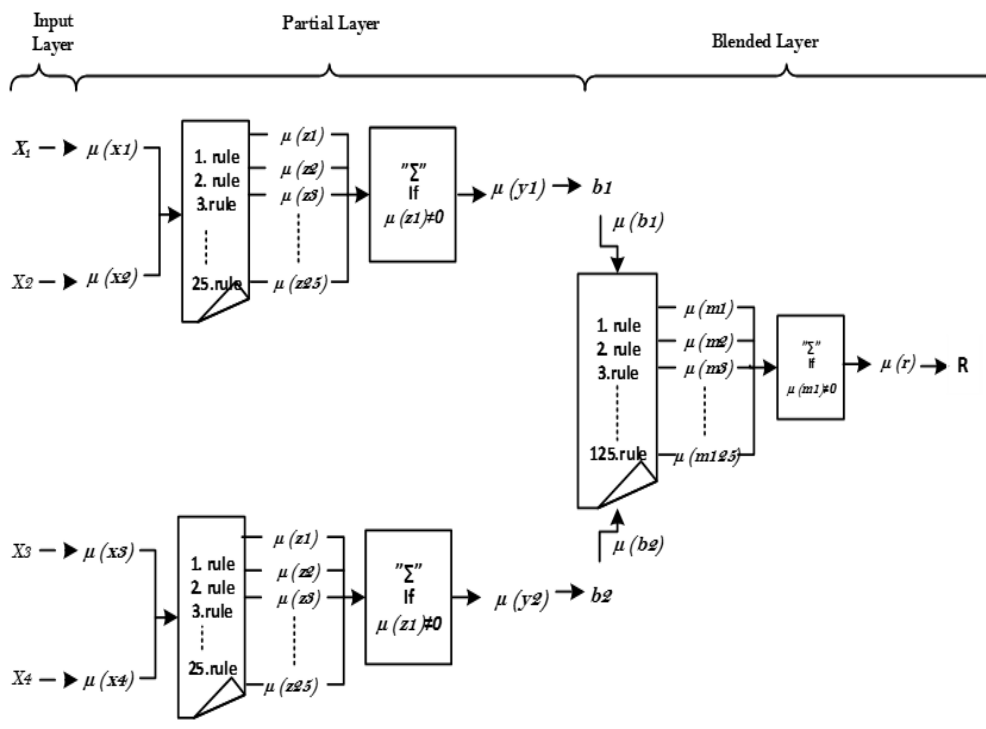
Figure 5. Detailed processing diagram of the blended hierarchical fuzzy model.